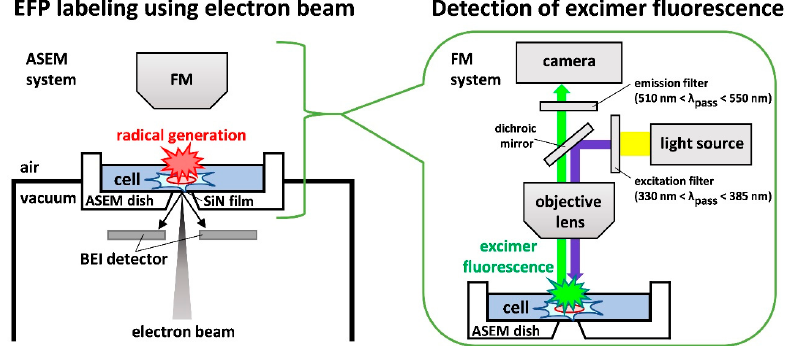
Figure 4. The atmospheric scanning electron microscope (ASEM) system for the EFP labeling and detection of pyrene excimer fluorescence of neighboring SH residues. The electron beam from the inverted SEM at the bottom was used to induce the thiol-ene click reaction (left), and the FM system at the top was used to visualize the excimer fluorescence (right). The electron-transparent silicon nitride (SiN) film windows [15] of the ASEM dish separates the atmosphere and the vacuum in the column [13]. Int. J. Mol. Sci. 2020 , 21 , x